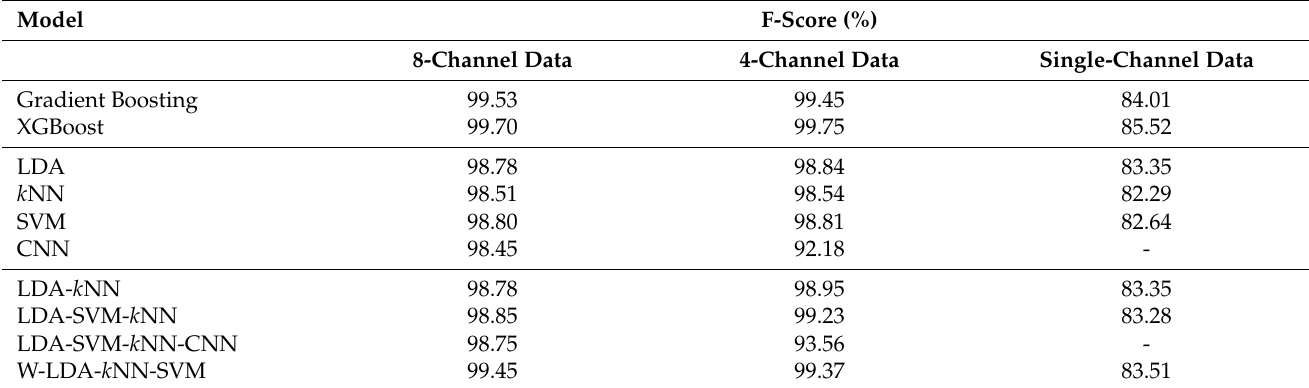
Table 1. Intra-Subject Test